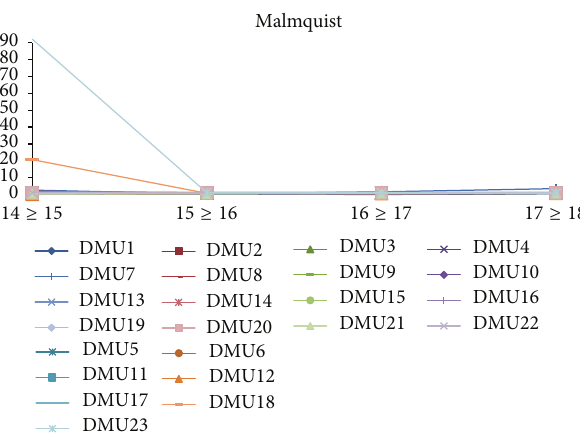
Figure 4: Productivity index (MPI) change over the period